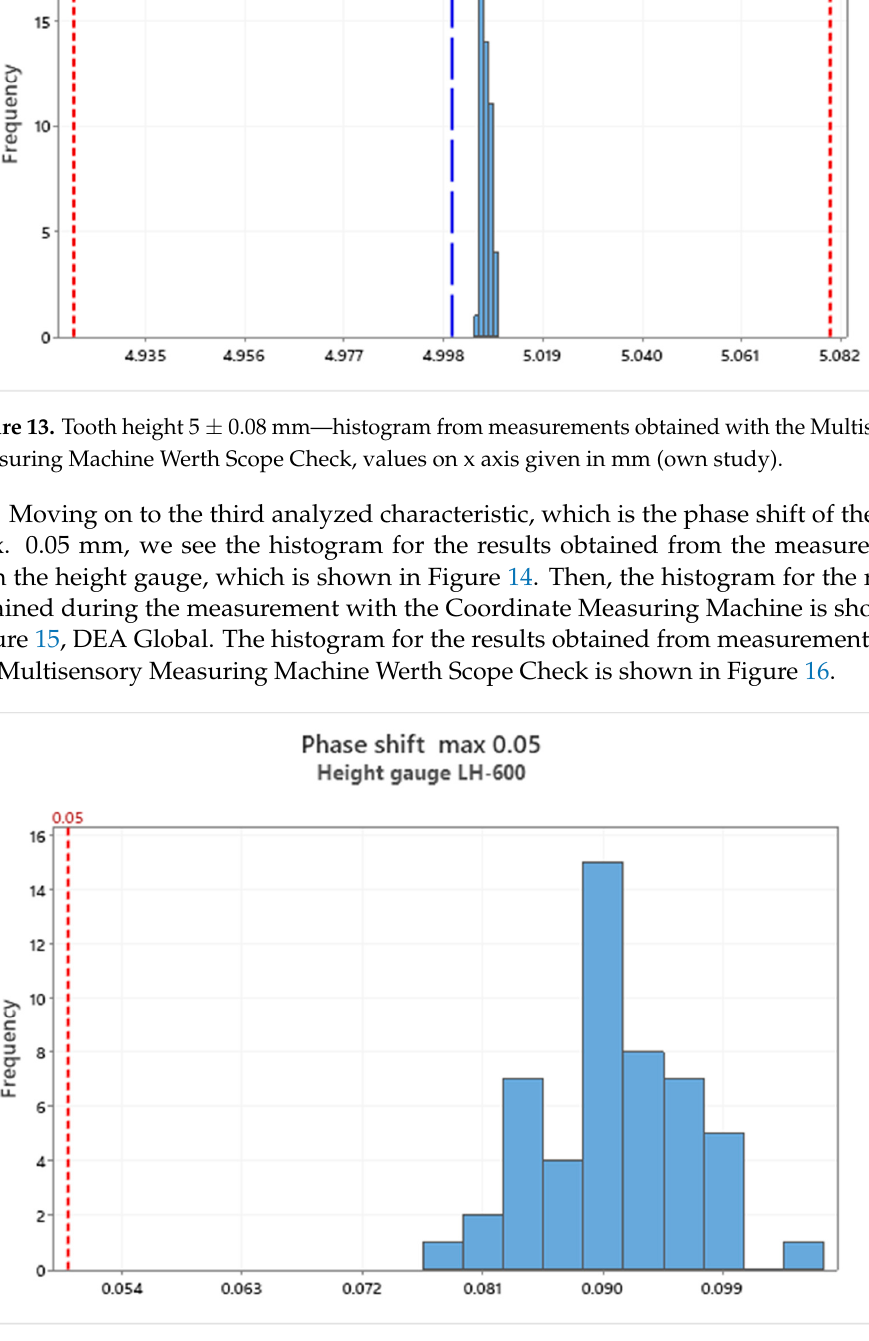
Figure 14. Phase shift of the teeth max. 0.05—histogram from measurements obtained with the LH-600 height gauge, values on x axis given in mm (own study).